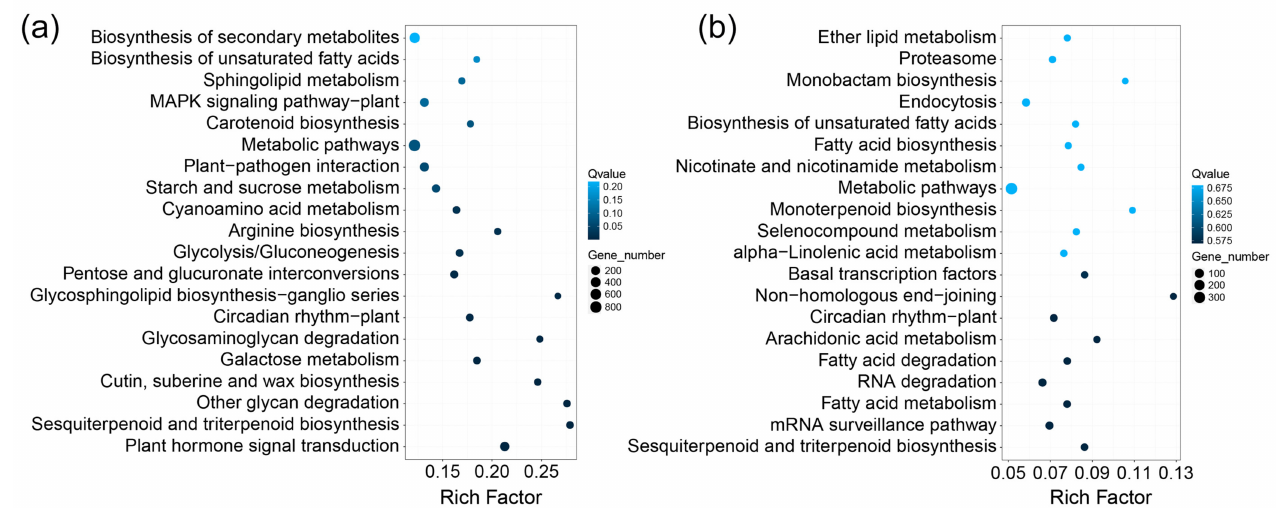
Figure 4. Kyoto Encyclopedia of Genes and Genomes (KEGG) pathway enrichment analysis of DEGs in the C-vs-Trp group ( a ) and S-vs-S+Trp ( b ) group. The X-axis represents the enrichment factor, and the Y-axis represents the pathway name. The depth of color represents the Q-value, and the size of the dot represents the number of